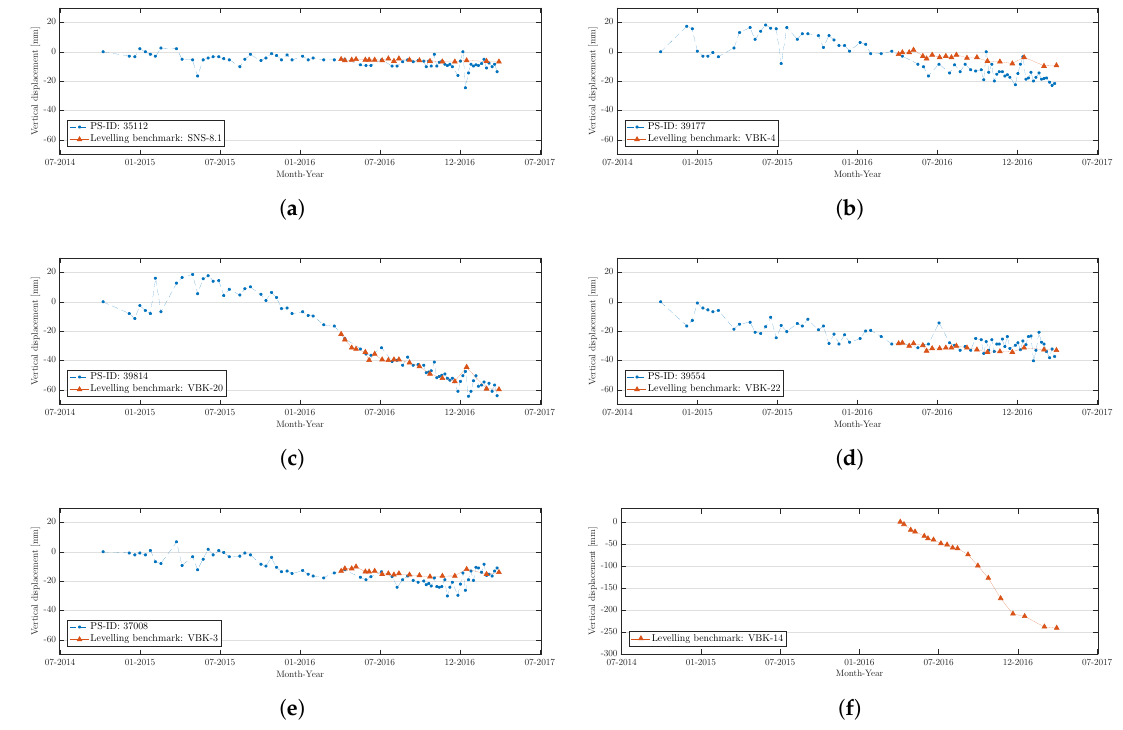
Figure 13. Comparison of PS deformation time series (from descending track, projected onto the vertical component) with levelling. Points ( a ) SNS-8.1; ( b ) VBK-4; ( c ) VBK-20; ( d ) VBK-22; ( e ) VBK-3; ( f )